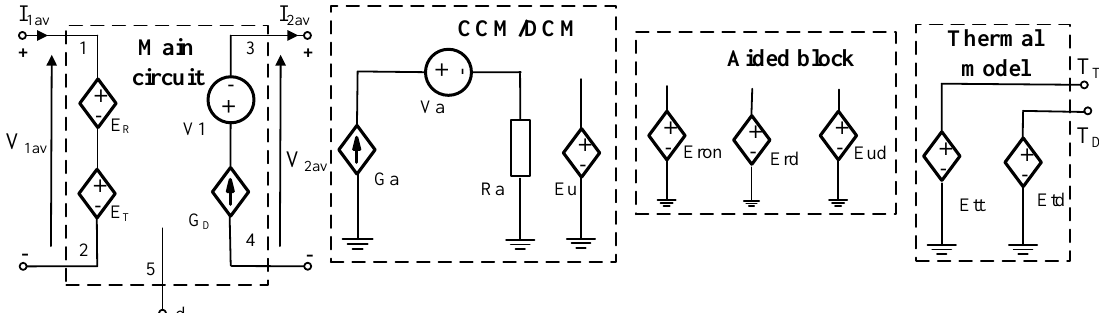
Figure 4. Network representation of the electrothermal model of the PWM switch including the power MOSFET.